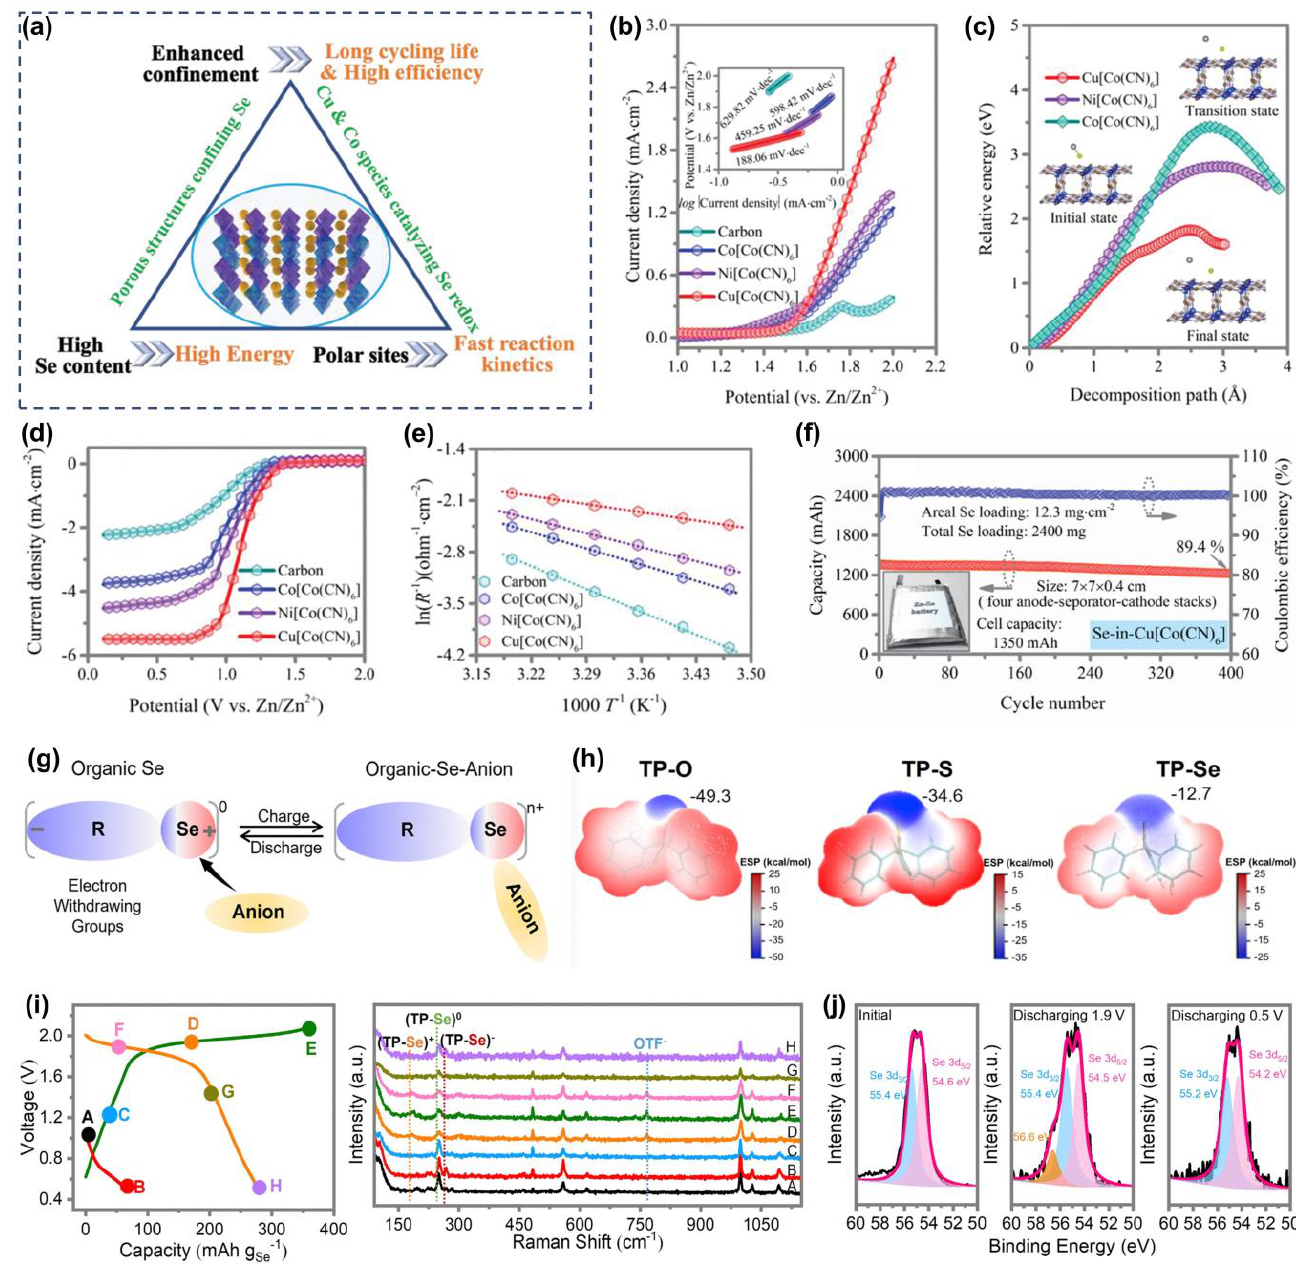
Figure 11. ( a ) Illustration of the cathode design for AZSeBs; ( b ) LSV curves and corresponding Tafel plots of (Cu/Ni/Co)[Co(CN) 6 ] for Se oxidation; ( c ) decomposition energy barrier of ZnSe on different hosts; ( d ) LSV curves of (Cu/Ni/Co)[Co(CN) 6 ] for Se reduction; ( e ) activation energies of different hosts; ( f ) cycling performance of the Ah-level pouch cell with high Se mass-loading (reproduced with permission from Ref. [97]. Copyright 2022, Wiley-VCH). ( g ) Schematic of the strategy for positive valence conversion of Se; ( h ) ESP mappings of TP-O/S/Se; ( i ) GCD curve at 0.5 A g − 1 and corresponding ex situ Raman spectra; ( j ) ex situ XPS spectra of Se 3d at different states (reproduced with permission from Ref. [69]. Copyright 2022,